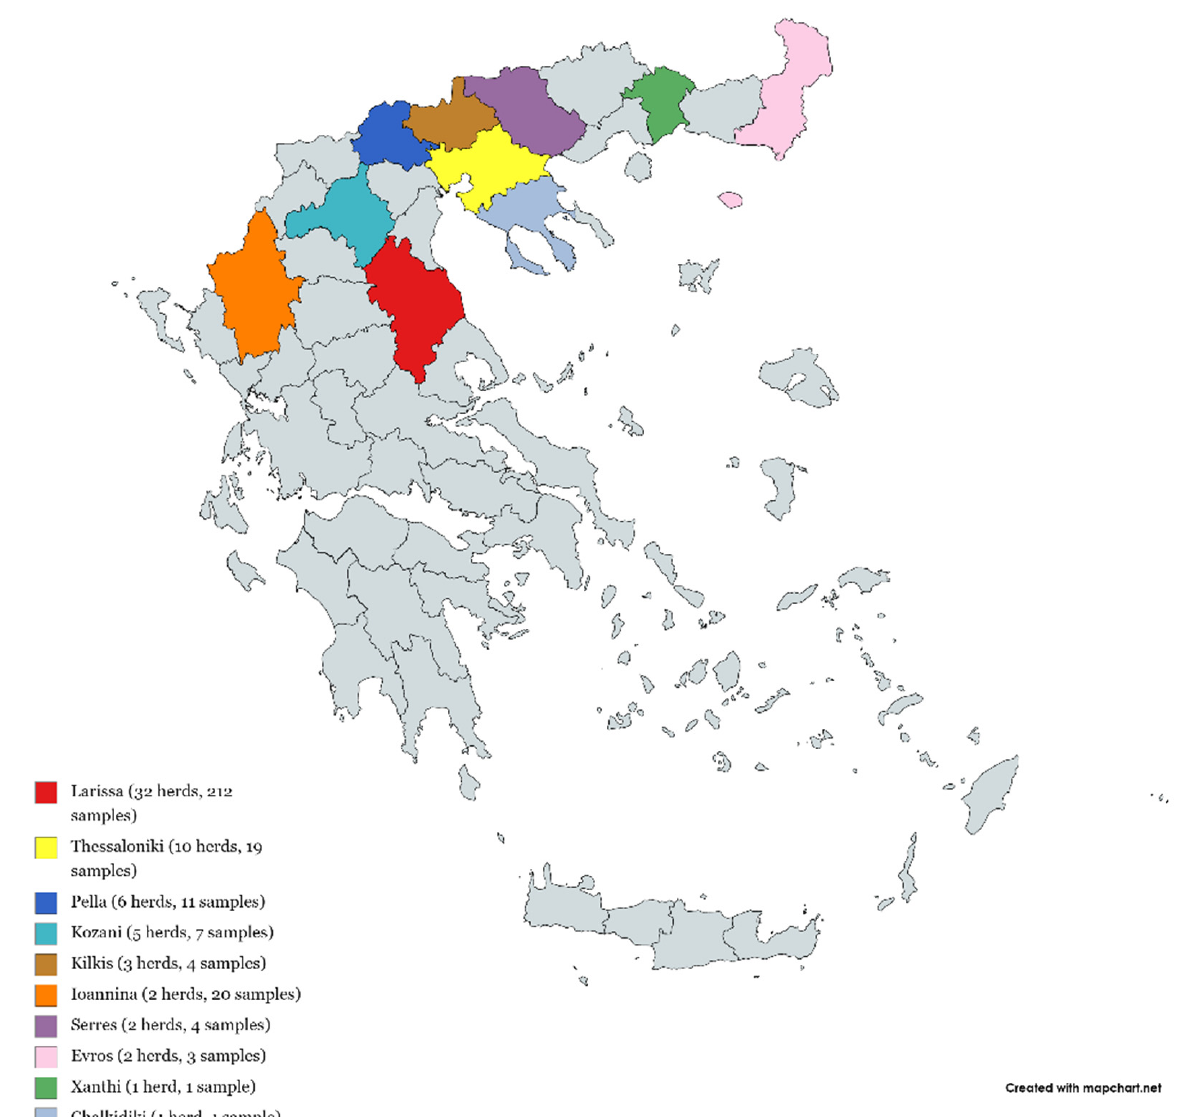
Figure 1. Distribution of the 64 herds and 282 brain samples found positive for scrapie. Blood samples were collected randomly from affected and non-affected herds, as a part of the standard veterinary clinical practice and were assayed within the EU EMIDA ERA-NET project entitled “Towards breeding of goats for genetically determined TSE resistance”. A total of 1708 blood samples was collected during a single farm visit from individual, clinically healthy goats reared in affected ( n = 12 herds, 241 samples) and non-affected ( n = 38 herds, 1467 samples) herds. Enrolled herds were in the prefectures of Macedonia and Thessaly, Dodecanese and Ionian Islands, and Thrace (Figure